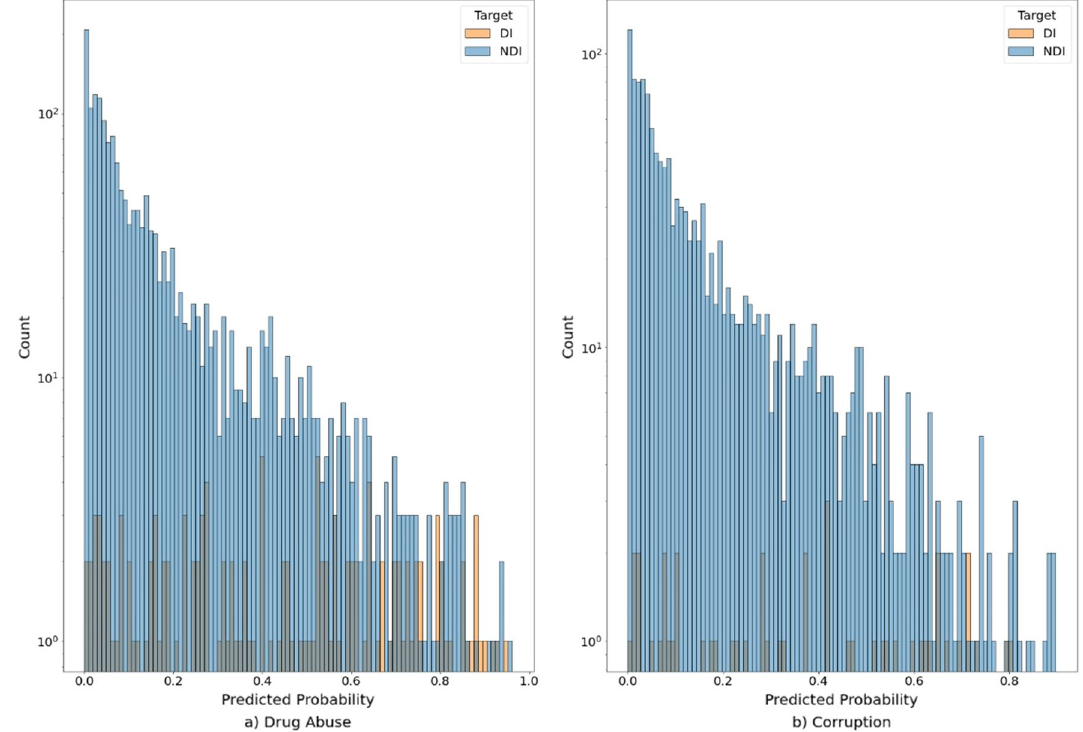
Figure 1. Distribution of basic model scores for topics: ( a ) “Drug abuse”; ( b )